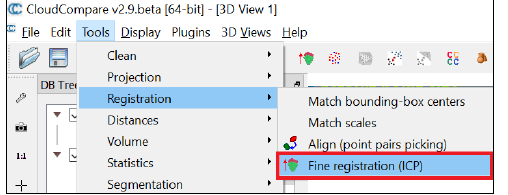
Figure 38. Fine registration (ICP) menu